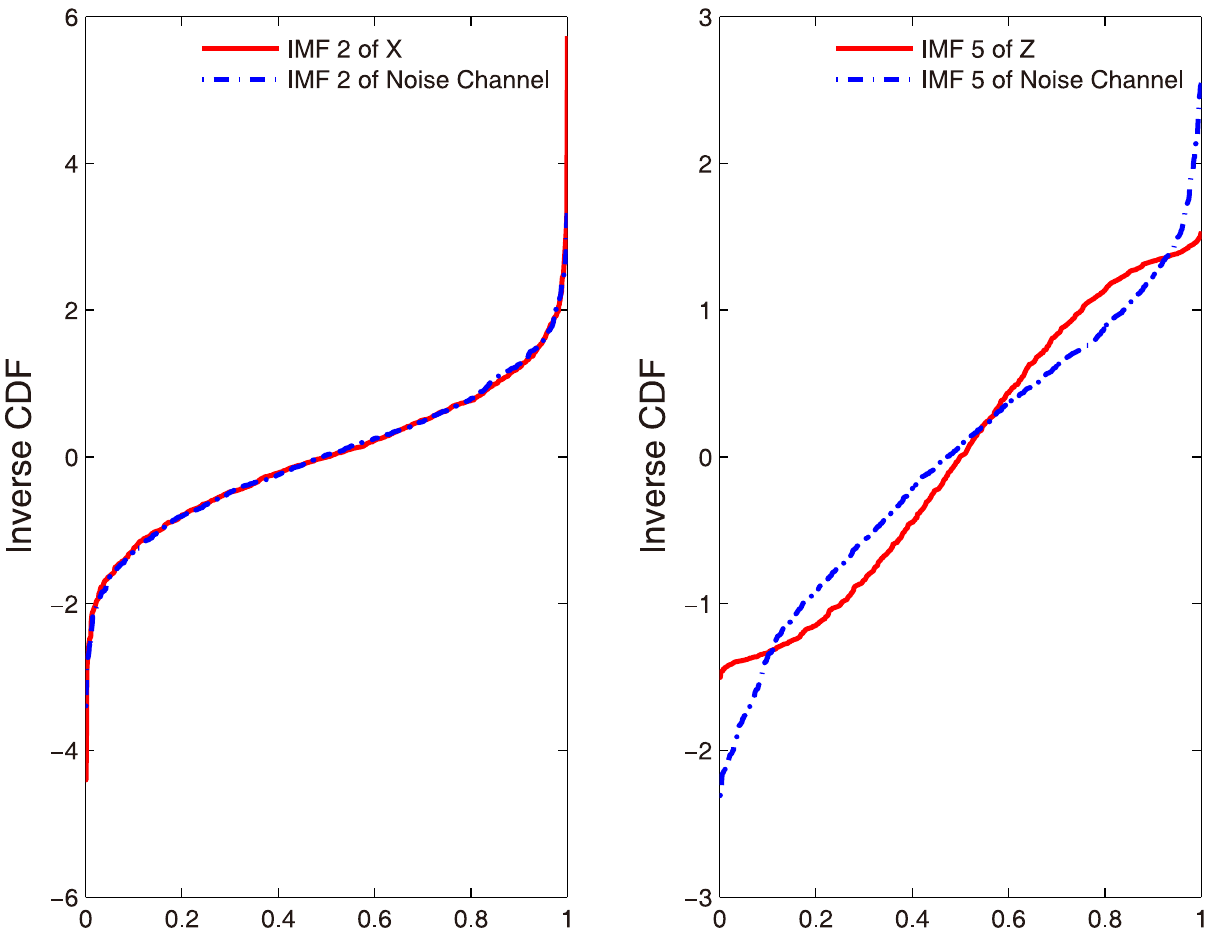
Figure 2. The inverse CDFs of IMFs, (A) IMF 2 of X and of the added noise channel; (B) IMF 5 of Z and of the added noise channel. Note that the IMF 5 of Z refers to the sine wave component of 26 Hz. It is clear that the significant information-bearing component (red solid in (B)) is clearly different from the IMF obtained from the noise reference (blue dash in (B)) in terms of inverse CDF, whereas the IMF without significant information content (red solid in (A)) almost completely overlaps with the noise IMF (blue dash in (A)).